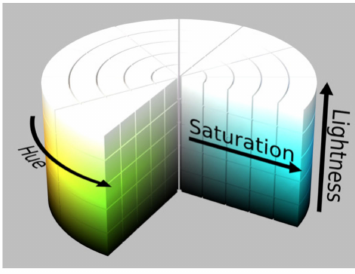
Figure 4. The HSL colour space.